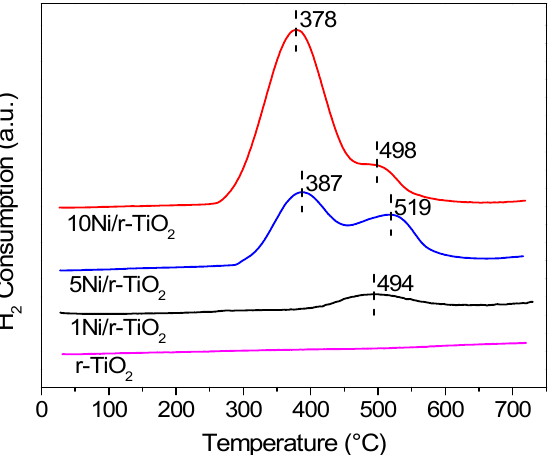
Figure 2. H 2 -TPR profiles for 1Ni/r-TiO 2 , 5Ni/r-TiO 2 , 10Ni/r-TiO 2 , and r-TiO 2 catalysts. Table 1. H 2 consumption and molar ratio of H 2 /Ni over 1Ni/r-TiO 2 , 5Ni/r-TiO 2 , and 10Ni/r-TiO 2 catalysts determined by H 2 -TPR.